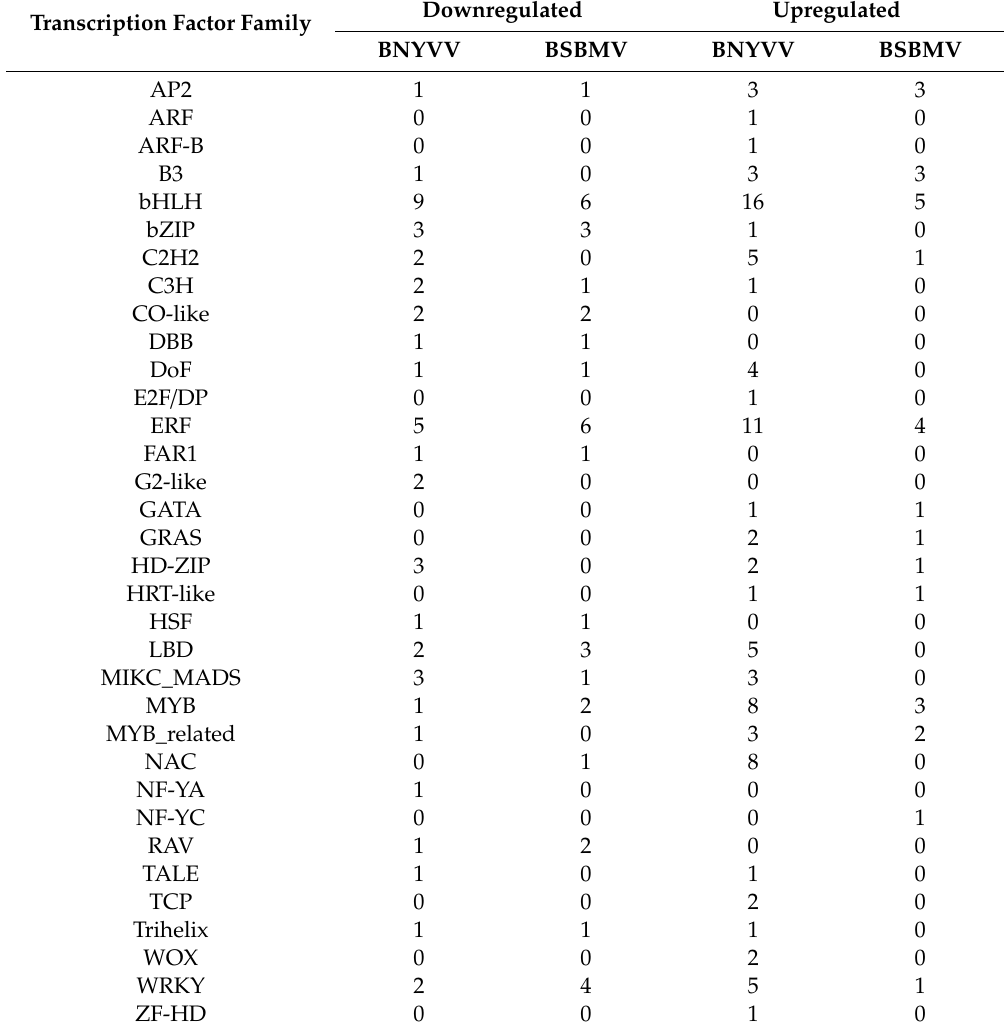
Table 5. Overview of di ff erentially expressed transcription factors identified in BNYVV- and BSBMV-infected